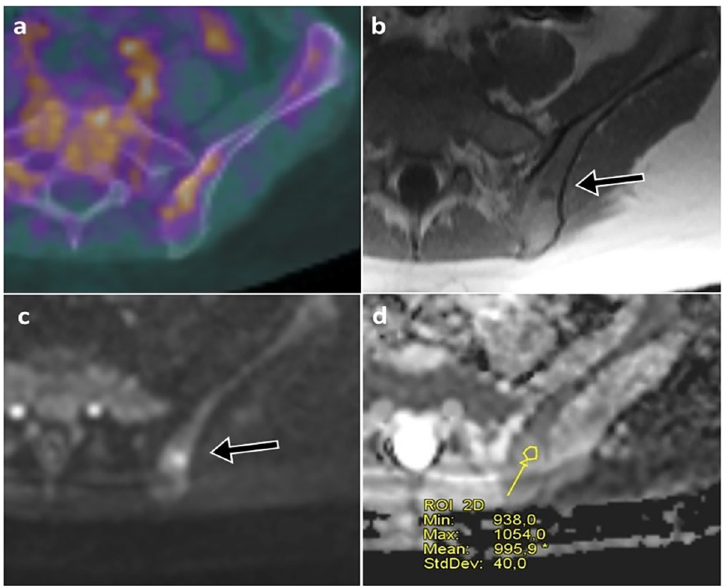
Fig 3. In the same pair of examinations of Fig 2, axial fused FDG-PET/CT showed non-specific FDG uptake in the pelvic bones (a). T1 weighted axial image from WB-MRI showed a suspicious bone lesion in the left iliac bone (arrow in b), which was hyperintense on b-900 DWI images (arrow in c) with low ADC values